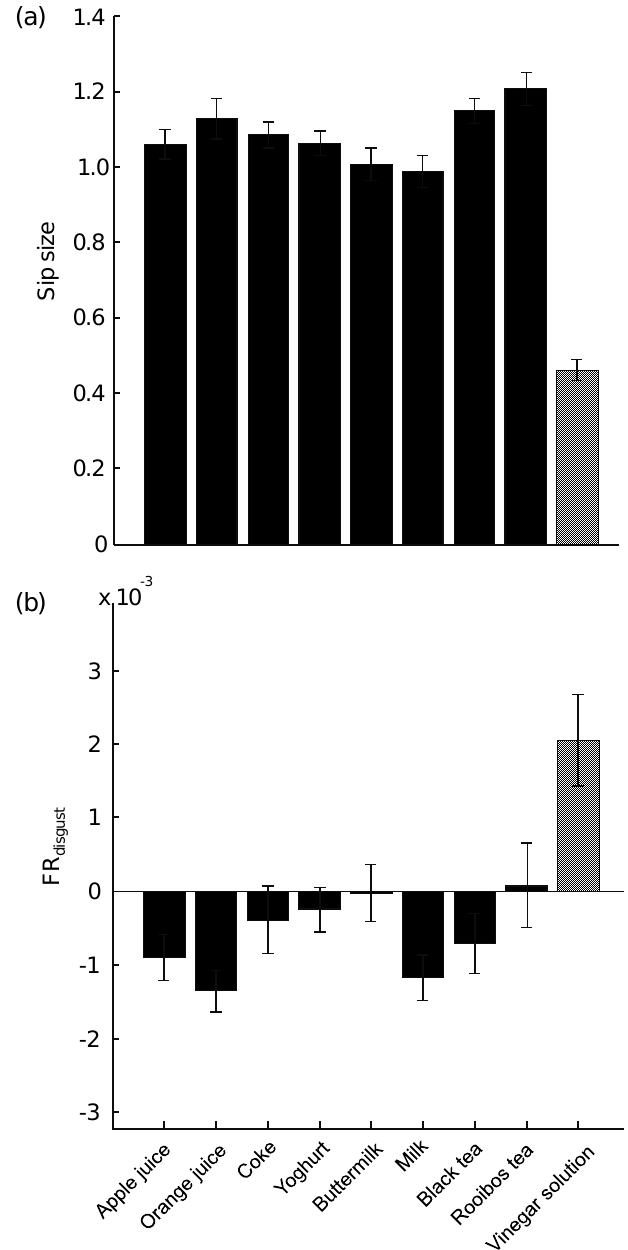
Figure 3. The results of behavioral measures: sip size ( a ) and FR disgust ( b ) averaged across participants. Solid bars represent the eight regular drinks, and the dotted bar represents the vinegar